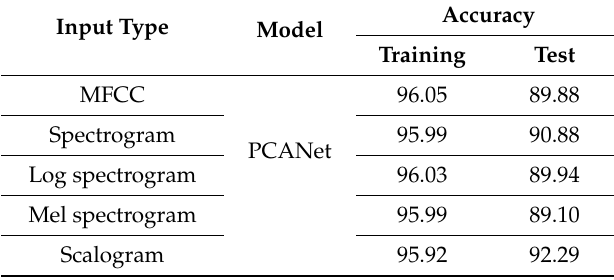
Table 5. Accuracies achieved by PCANet using time-frequency representations on